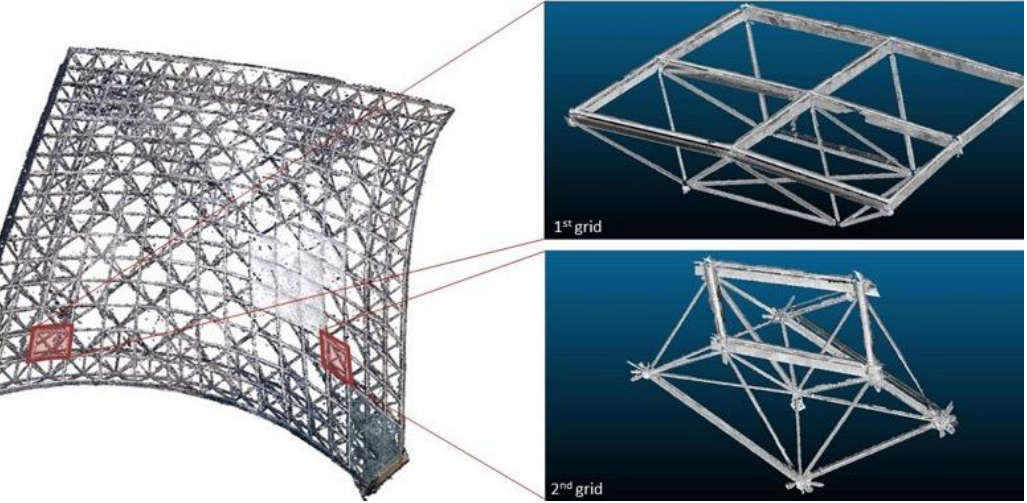
Figure 14. Two selected mesh grids for the LoR analysis.